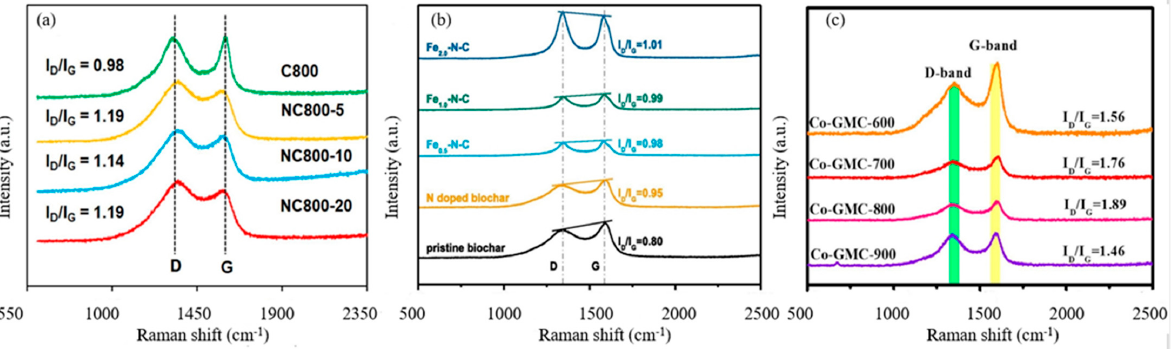
Figure 9. ( a ) Raman spectra of various catalysts [60], copyright 2020, Elsevier; ( b ) Raman spectra of